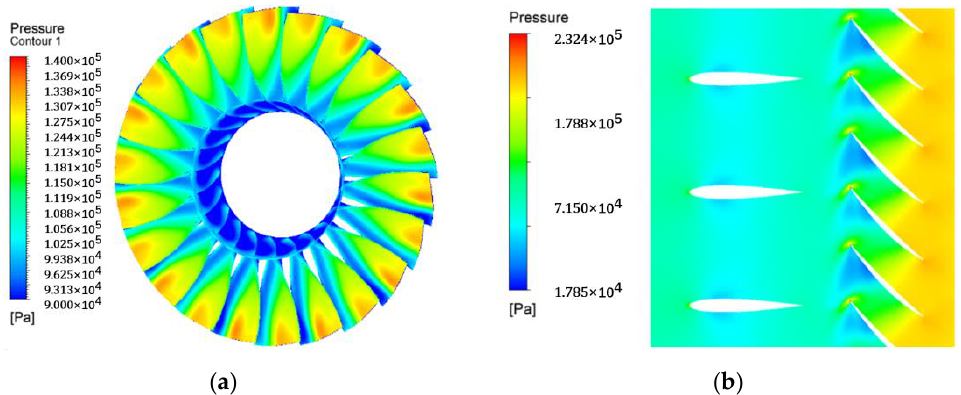
Figure 4. The ( a ) cloud picture of the pressure field behind the rotor blade; ( b ) cloud picture of static pressure field distribution at 50% blade height.